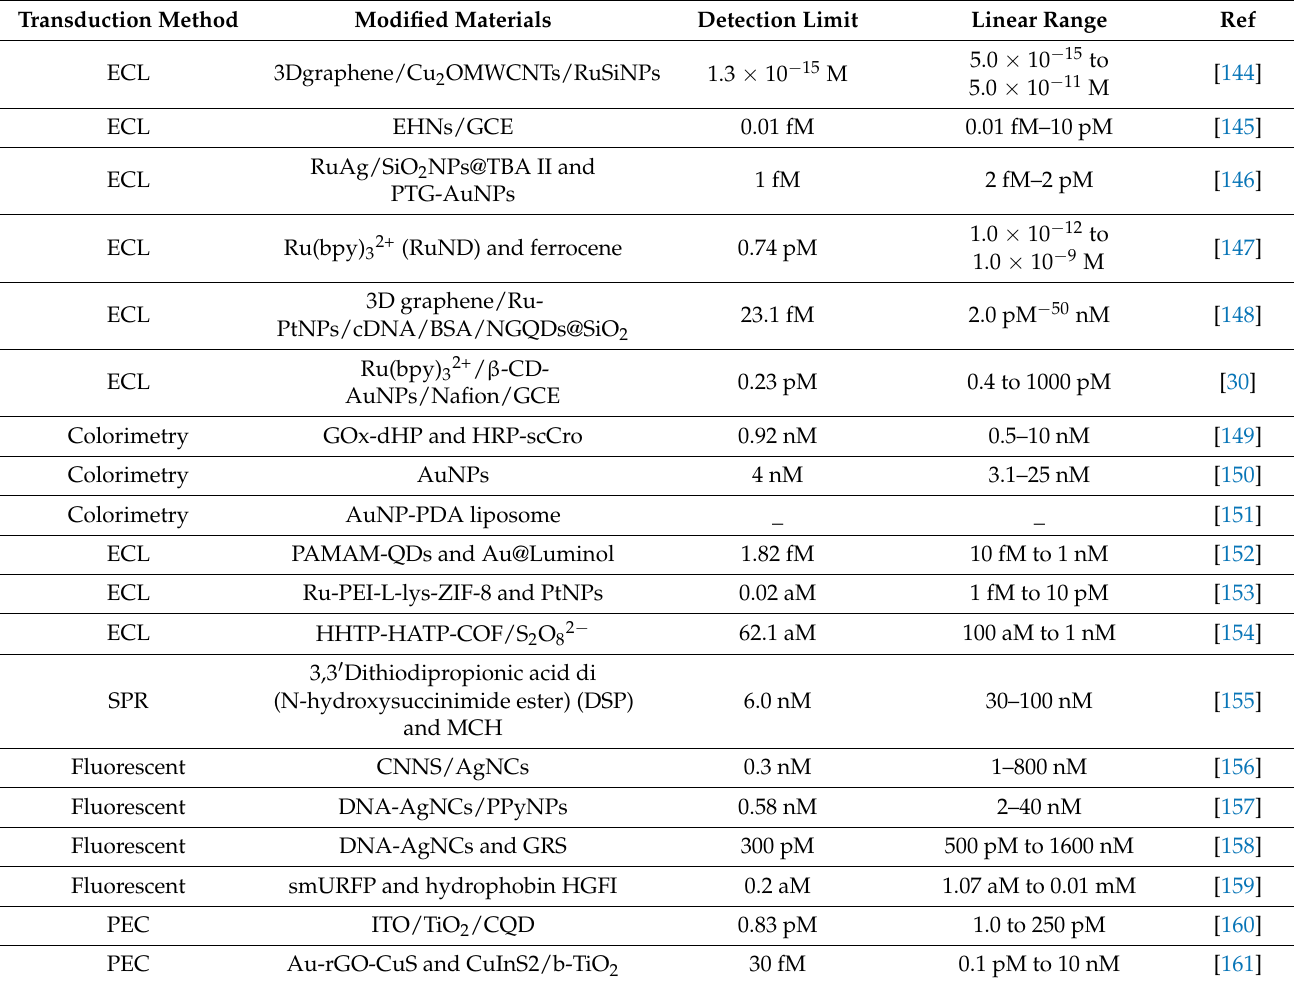
Table 2. The proposed optical biosensors for the determination of